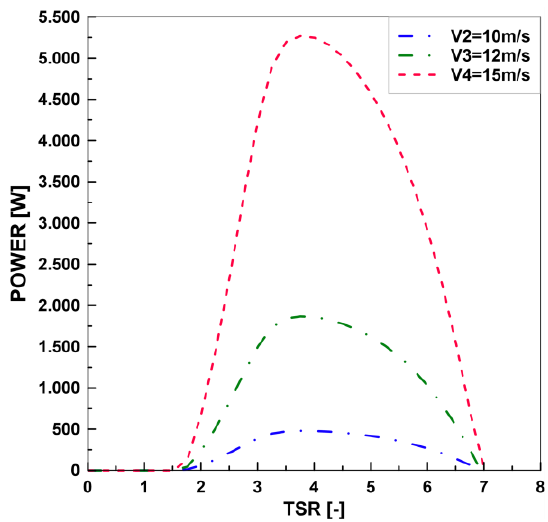
Figure 15. Effect of increasing wind velocity and height on the rotor’s power coefficient. Figure 15. E ff ect of increasing wind velocity and height on the rotor’s power coe ffi